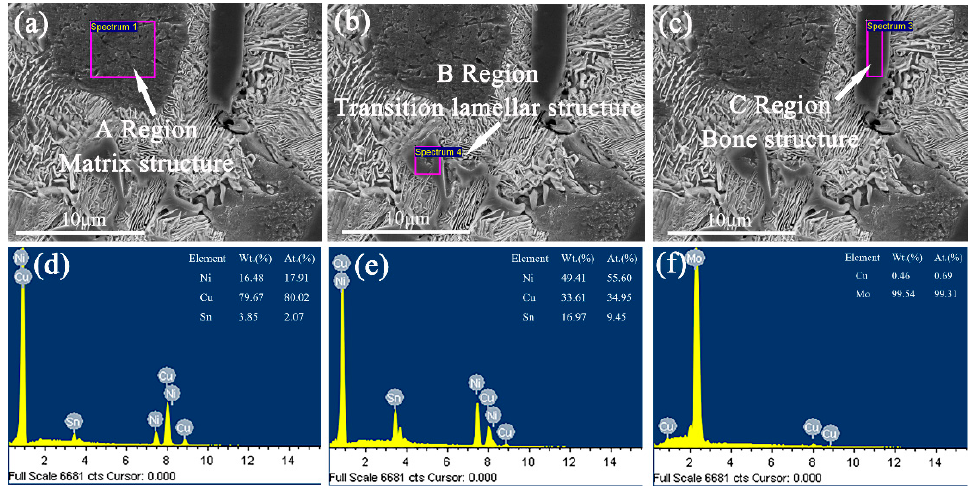
Figure 7. The SEM images of as-cast structure for Cu–15Ni–8Sn–1.5Mo alloy: ( a , d ) matrix structure, ( b , e ) transition lamellar structure, ( c , f ) bone structure. Table 2. Atomic weight percentage of Cu–15Ni–8Sn–xMo (x = 0.3, 0.9, 1.5 wt.%) alloys.